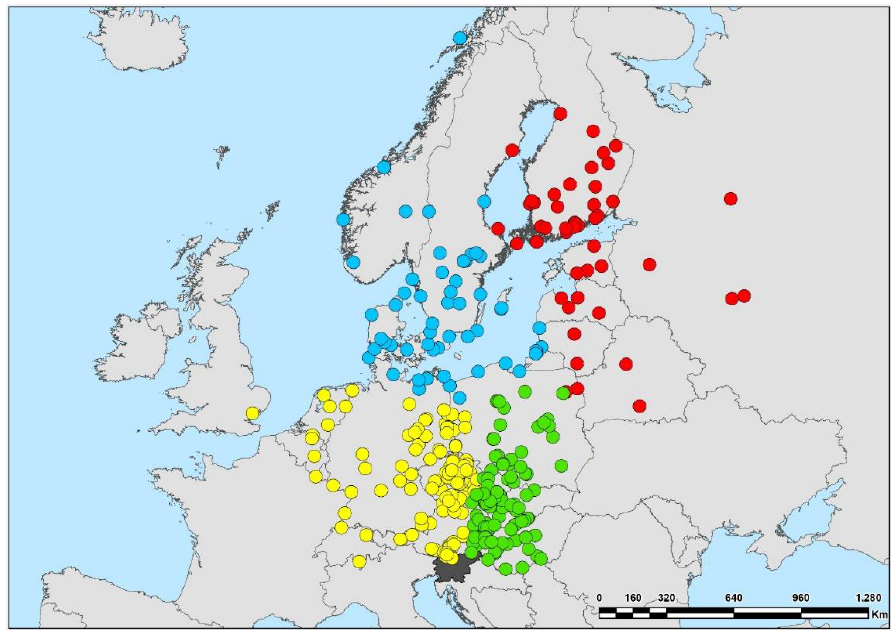
Figure 1. Spatial clustering of migratory passerines according to recoveries with defining four clus- ters of bird origin (yellow dots — North Western (NW), green dots — North Eastern (NW), red dots — North-North-Eastern (NNE), blue dots — North-Northern (NN)) according to the position to Slove- nia (shaded in dark) within